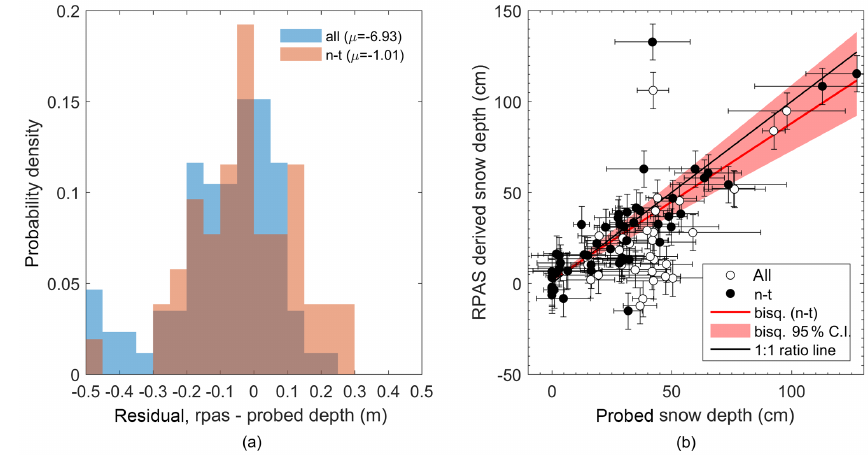
Figure 4. Residuals between snow depths measured by RPAS photogrammetry and probing for all probe locations (“all”, blue) and non- tussock probe locations (“n-t”, red) (a) , and bi-square (bisq.) weighted regression between snow depth derived from a 0.15m RPAS grid and probed snow depths (b) . Vertical error bars are determined from the error propagation associated with DSM differencing and have a magnitude of ± 0 . 094m, while horizontal error bars are calculated from the standard deviation of probe measurements made at each reference sampling location.